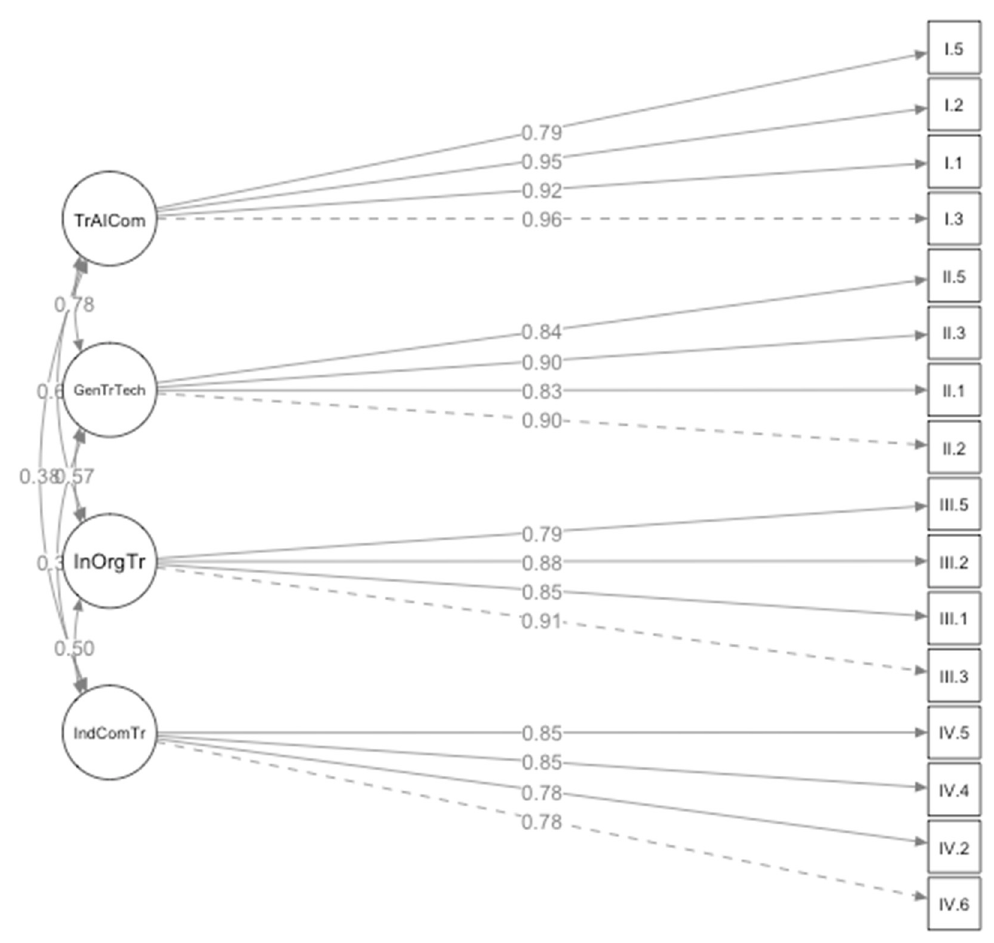
Energies 2021 , 14 , x FOR PEER REVIEW Figure 1. Measuring model (standardized loads are presented on the arrows). Figure 1. Measuring model (standardized loads are presented on the arrows).